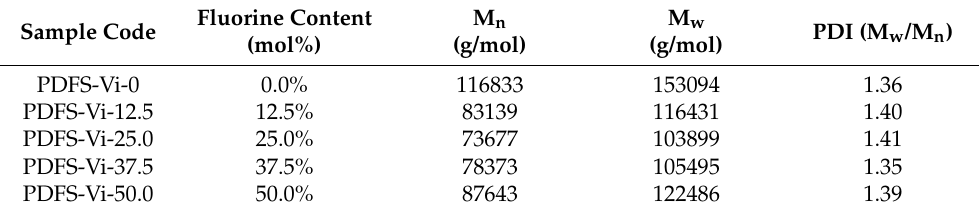
Table 1. Molecular weight values of PDFS-VI-X with different fluorine